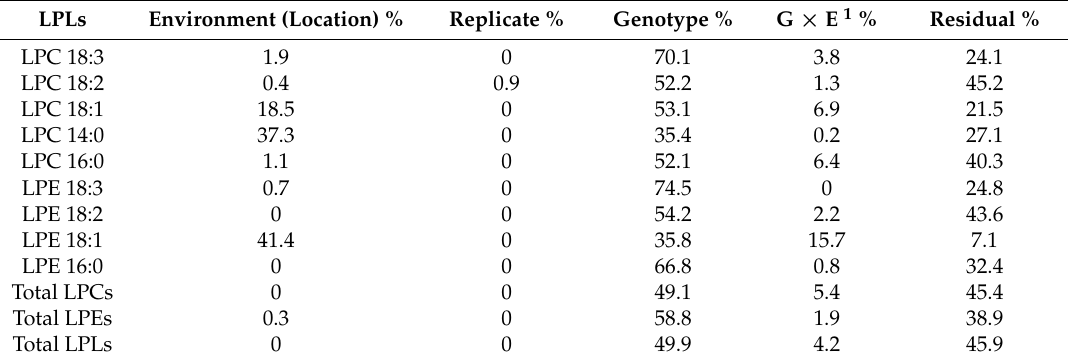
Table 3. Estimated percentage contribution of genotype, environment, and genotype × environment to total variance using restricted maximum likelihood (REML)